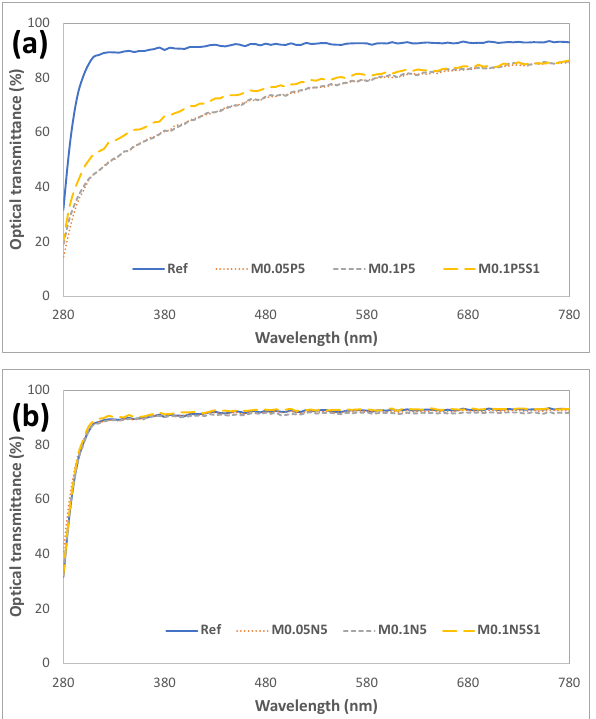
Figure 3. Optical transmittance of samples. ( a ) PVP group; ( b ) NVP group.